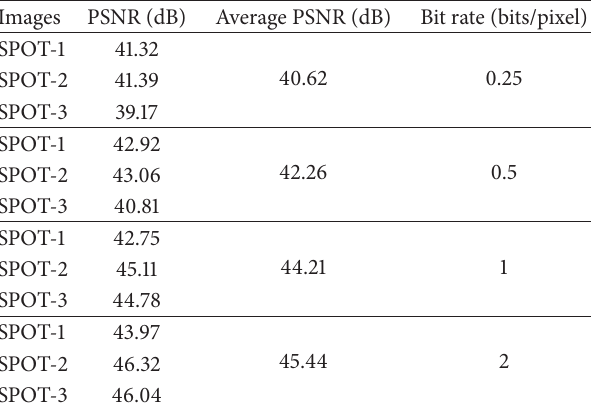
Table 2: Test results of